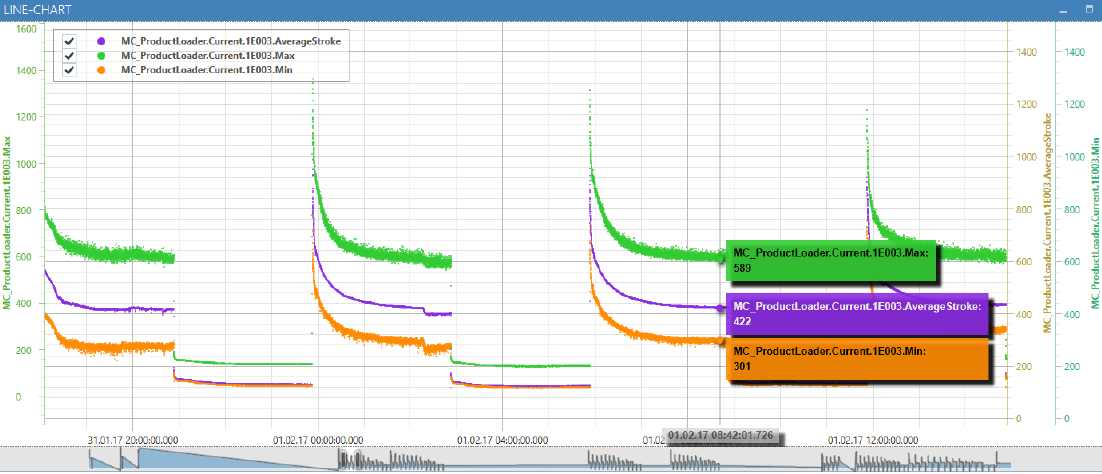
Figure 18. User interface of the SPP data